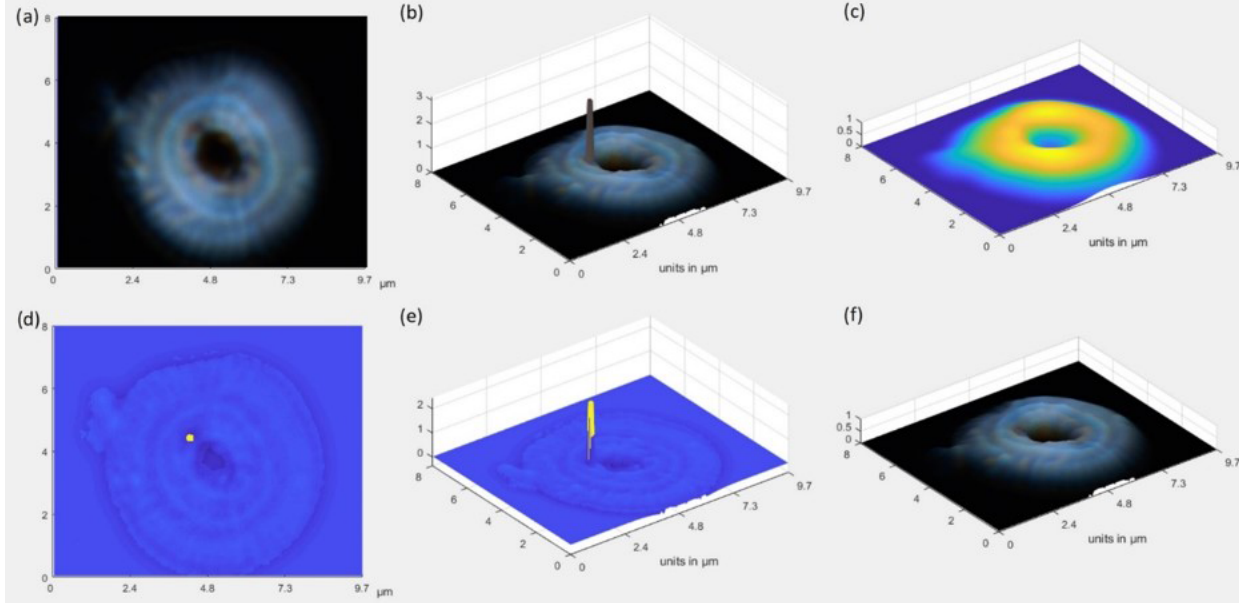
Figure 2. (a) Original image. (b) 3D coccolith with total thickness accumulated through the crystal (i.e., proximal and distal shield and tube calcite from coccolith r units), presenting in some points values higher than expected. (c) Gaussian smoothing. (d, e) Identification of points to be smoothed (yellow). (f) Final 3D image where the identified points have been